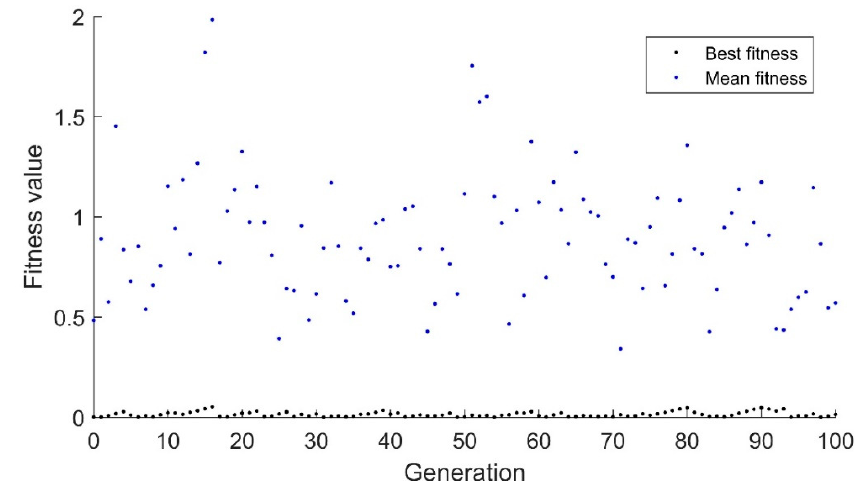
Figure 2. A real-valued genetic algorithm using a normally distributed mutation with standard deviation of 0.01 responding to a moving goal after initial convergence.